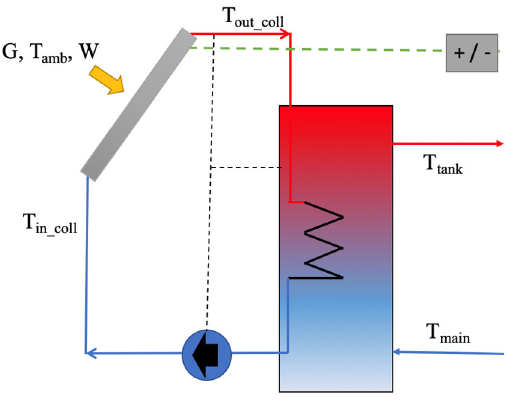
Figure 5. PVT system diagram.